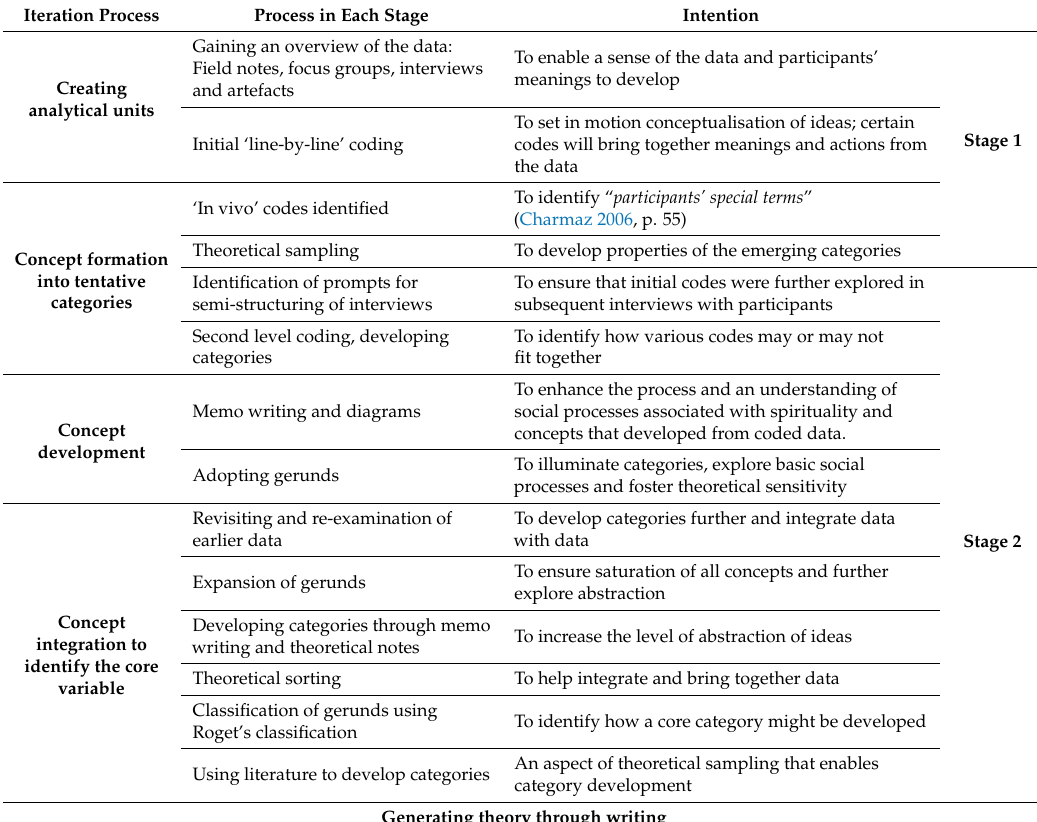
Table 1. Process of data analysis and integrating (Glaser